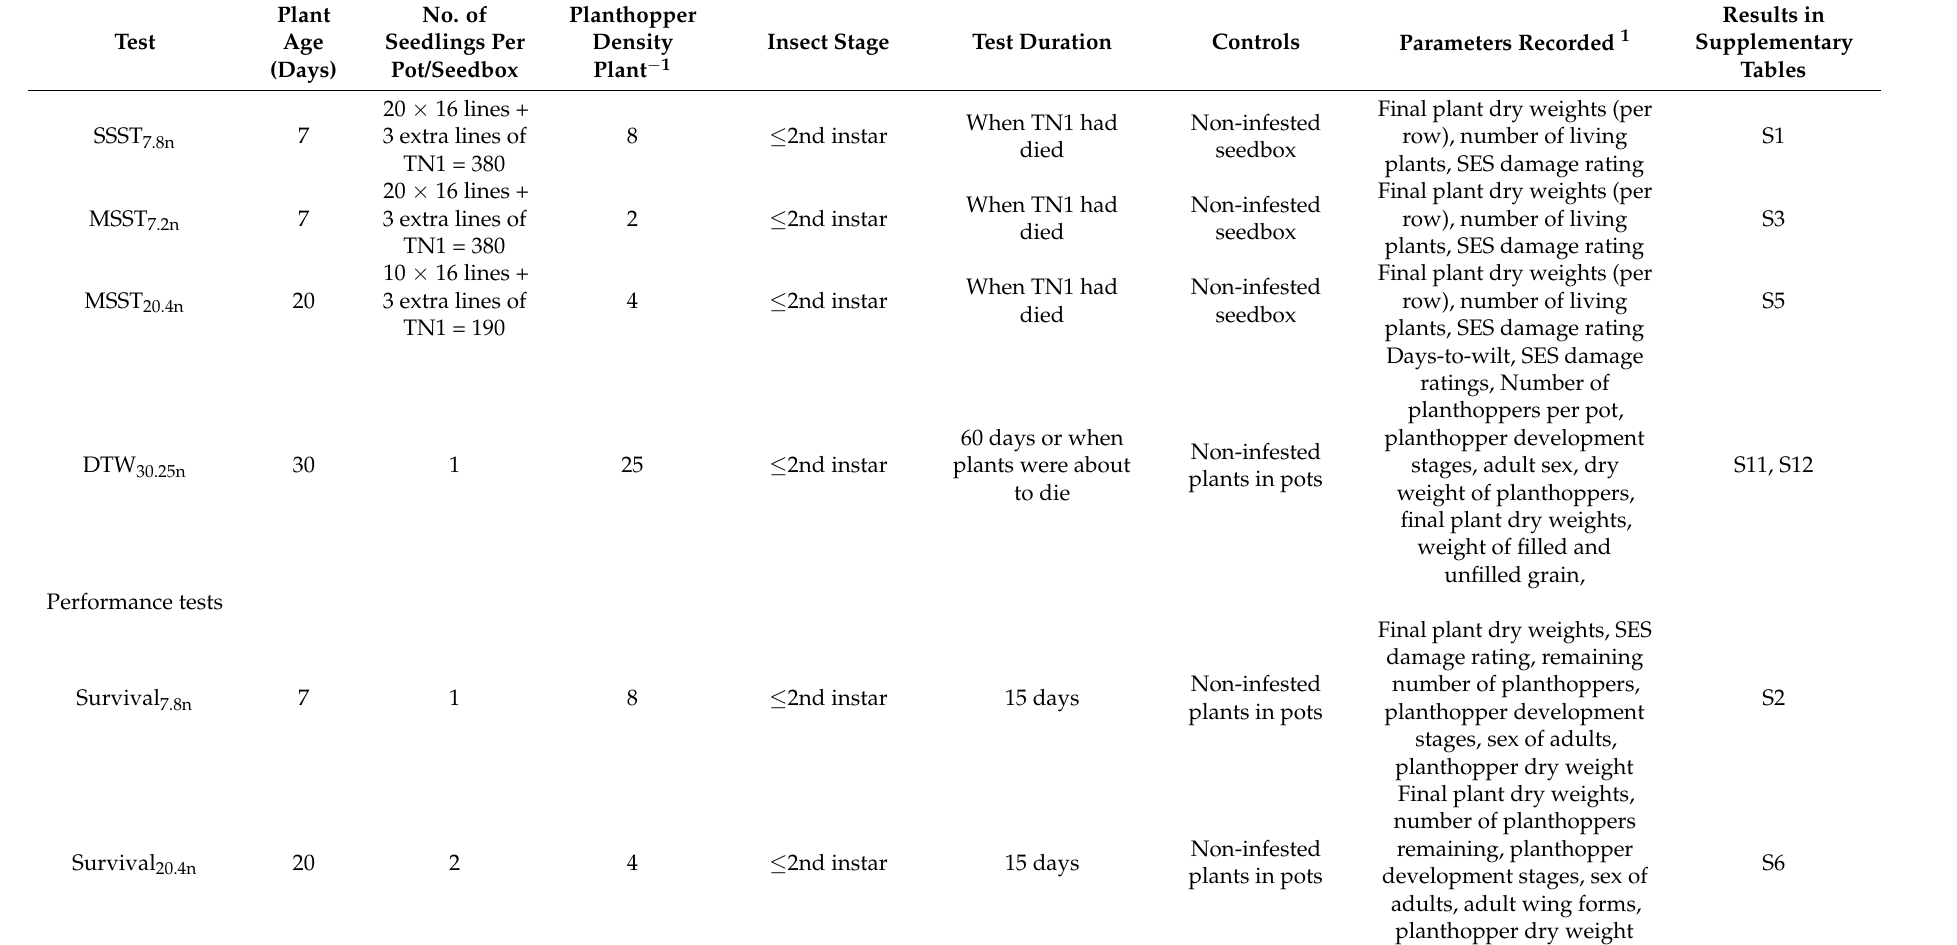
Table 1. Details of tests conducted in this study including the location (table number) of detailed results for each test in the supplementary